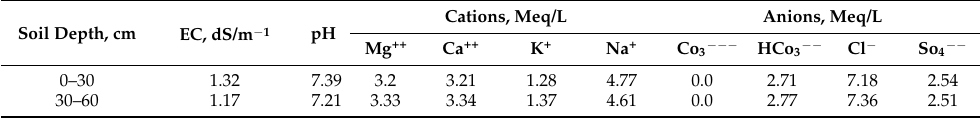
Table 1. Some chemical analysis of the experimental soil at different depths.